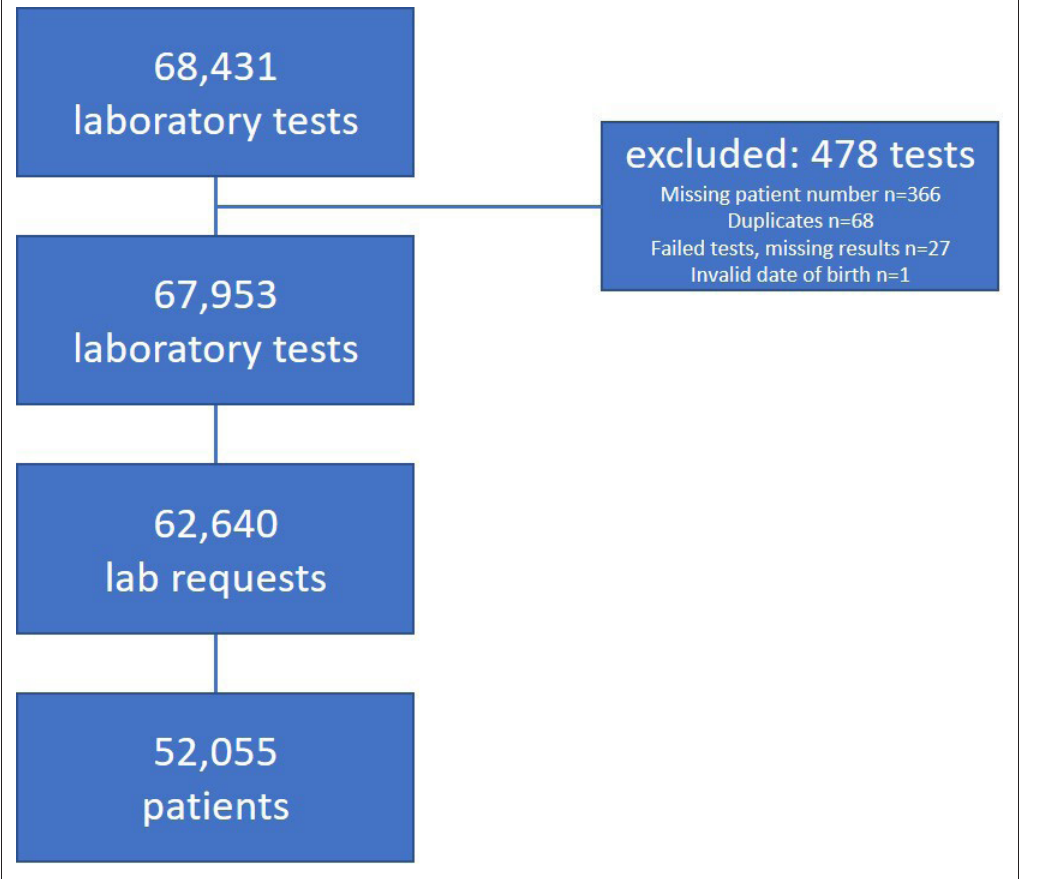
Figure 1 Exclusion of tests and number of remaining tests, requests and